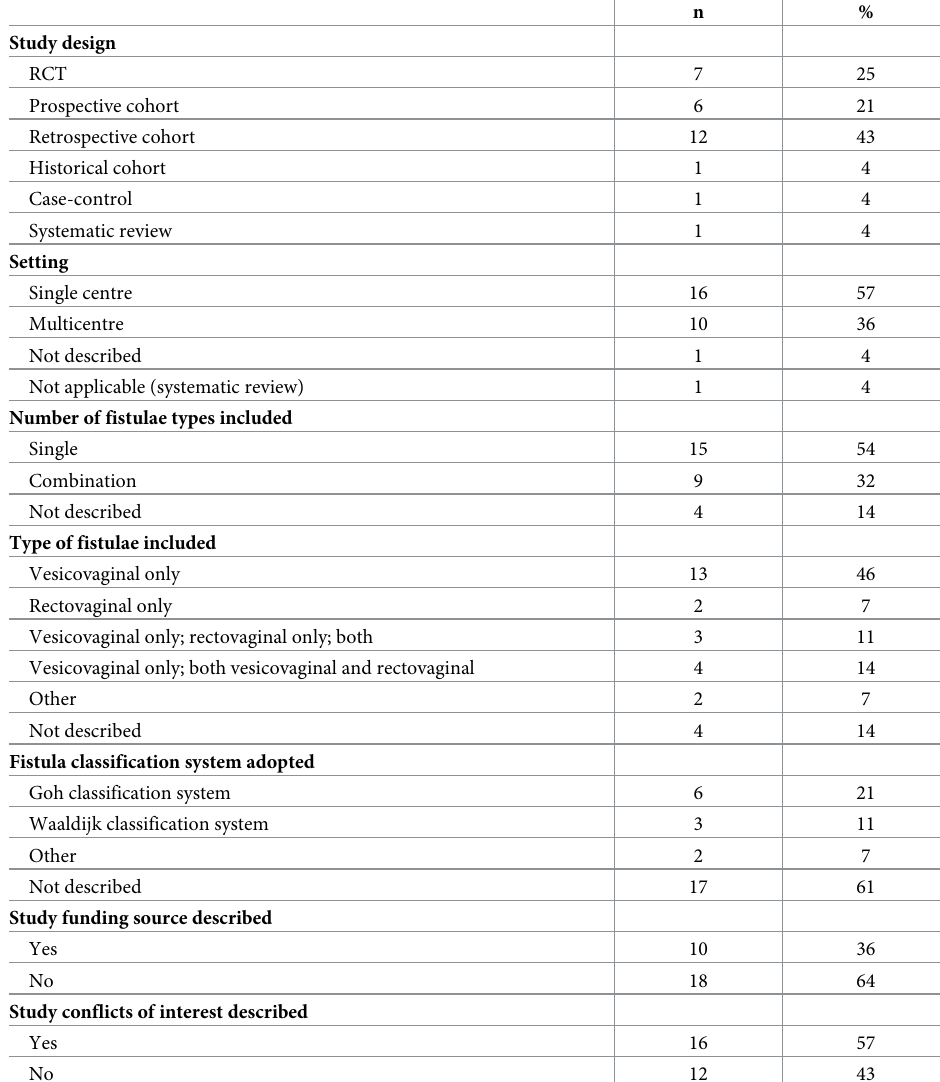
Table 4. Characteristics of included studies (N =